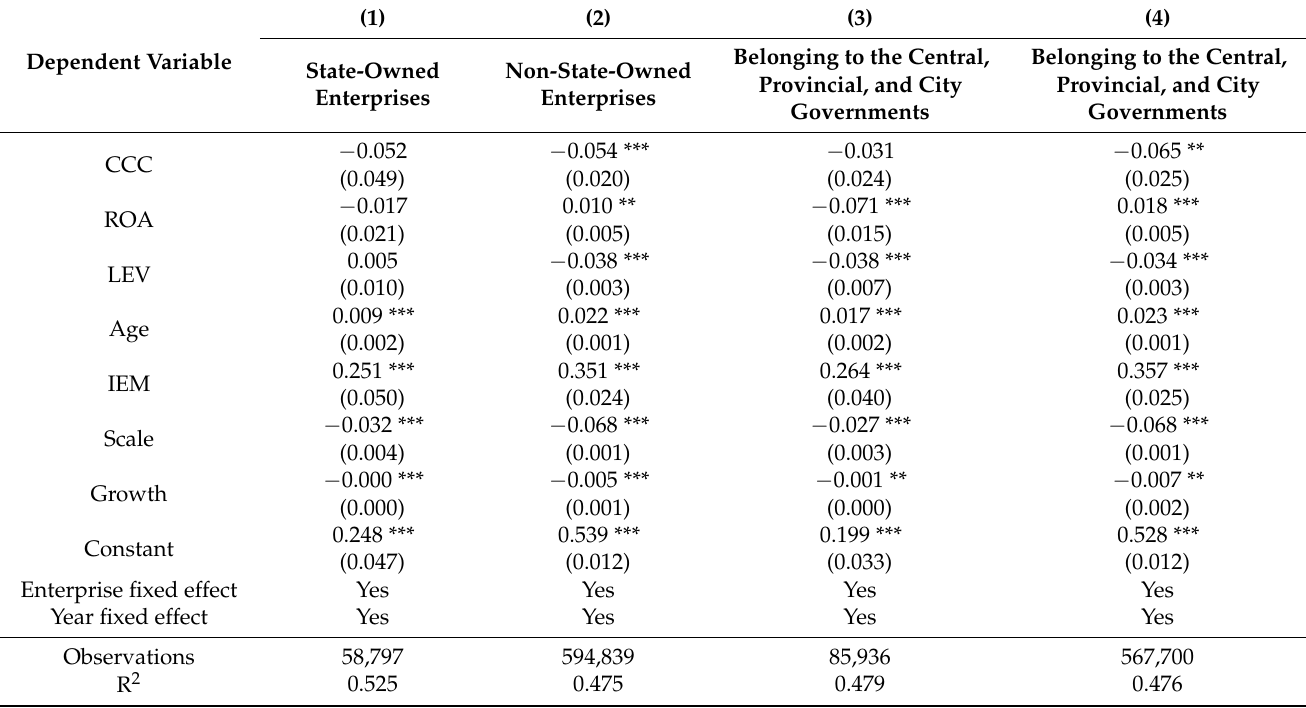
Table 4. Regression results of heterogeneity